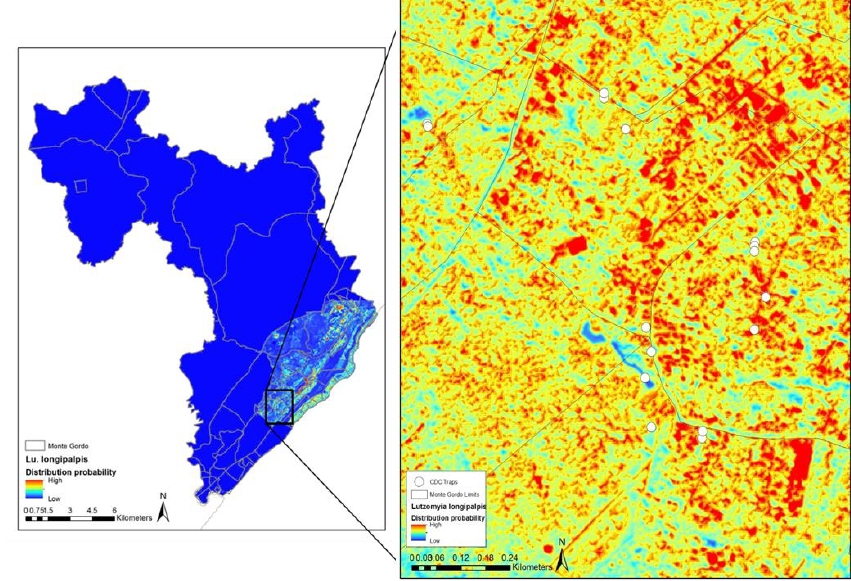
Figure 3. Maxent predicted the suitability for Lutzomyia longipalpis in Monte Gordo community-based on CDC trap data points and sub-meter spatial resolution WorldView2 imagery. The administrative boundaries of the municipality and districts (red lines) of Camacari, Bahia, Brazil are shown in the left panel. The predicted suitability of Lutzomyia longipalpis in Monte Gordo district is shown in the right panel based on CDC trap data and three vegetation indices derived from WorldView2 imagery, normalized difference vegetation index (NDVI), normalized difference soil index (NDSI), and normalized difference water index (NDWI). The inset box shows the model output and CDC trap locations. Highly suitable areas for the vector are shown in red.